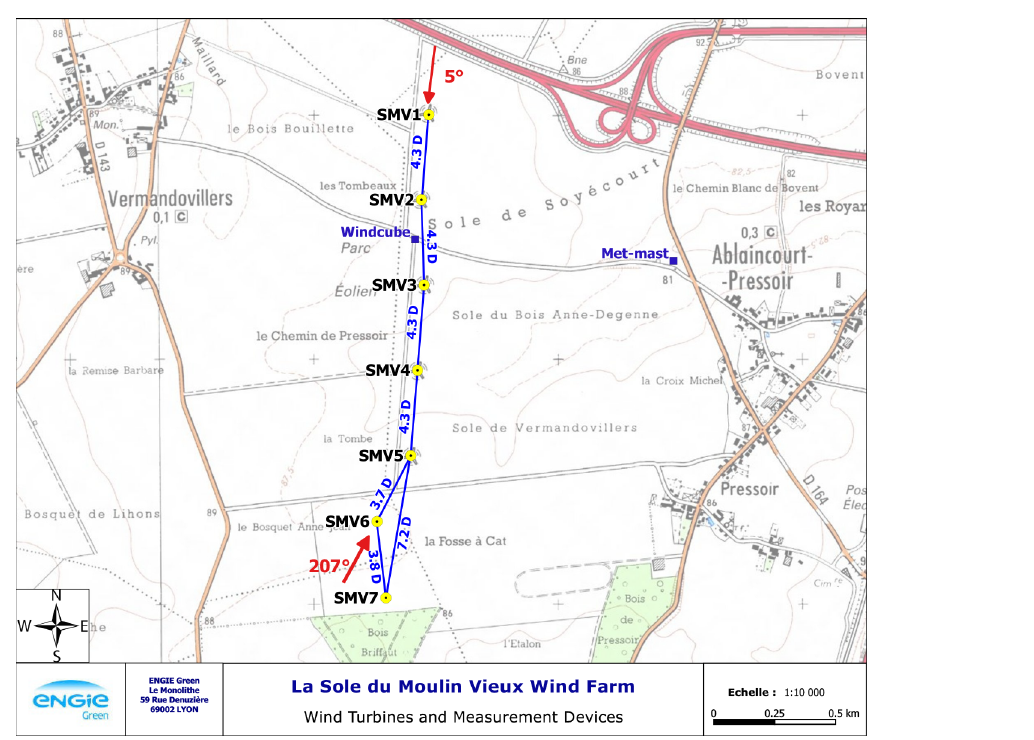
Figure 1. Layout of the SMV wind farm and location of wind measurement devices. Interdistances between the wind turbines are expressed in rotor diameters (with D = 82m), while red arrows indicate the main wind direction angles used in this paper.